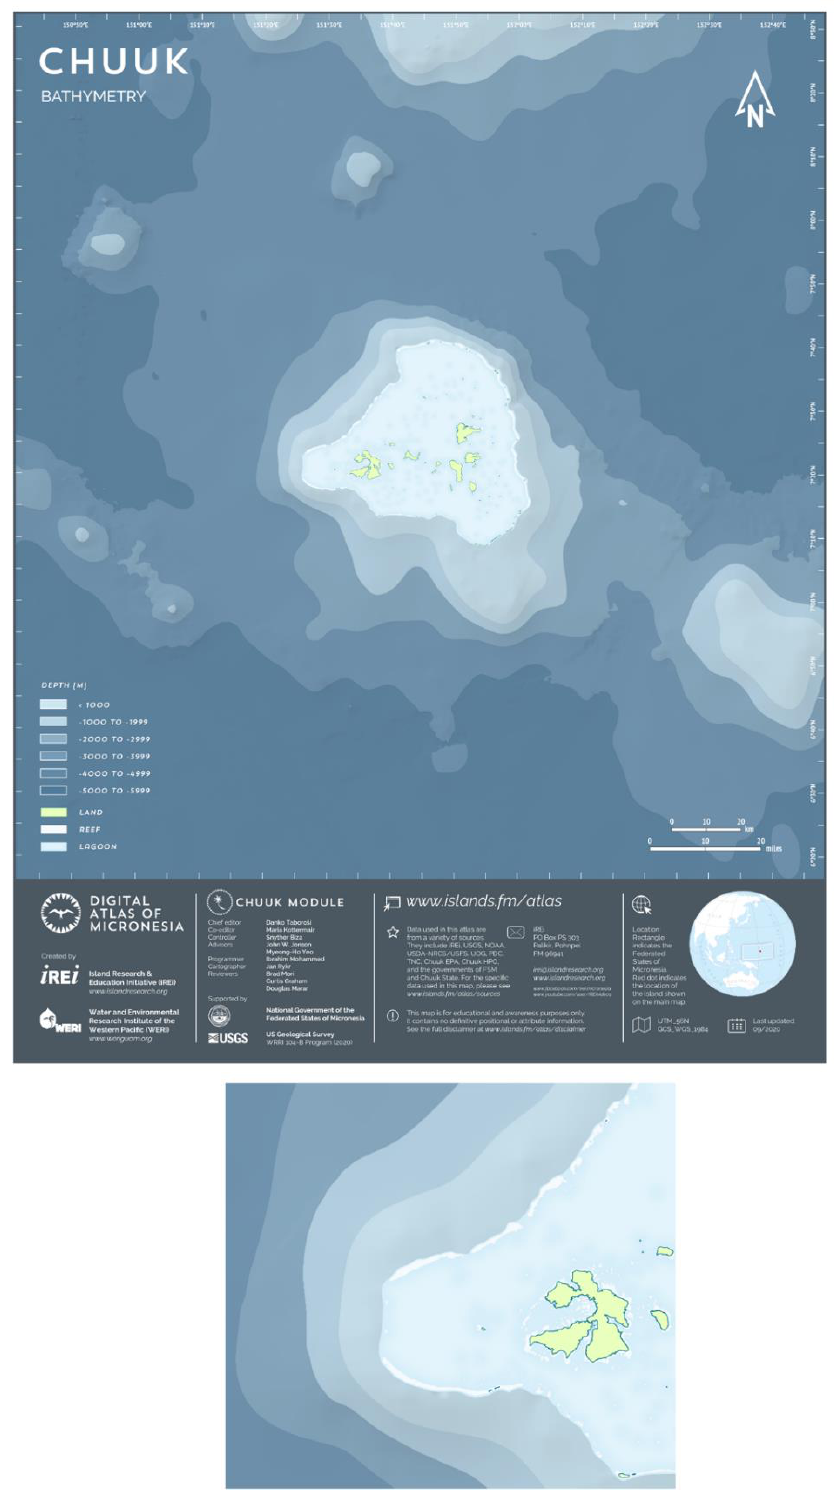
Figure 14. ( top ) Bathymetric map of Chuuk Lagoon and surrounding waters [23]. This map is shown much smaller than full size; at full size, available at https://islandatlas.org/chuuk/reefs/ (accessed on 26 Aug 2022), it confirms the locations of the reefs of the atoll and the gaps between reefs that are apparent in the MODIS image shown in Figure 14. ( bottom ) Subset image from the full-size bathymetric map, showing the bathymetry on the west side of Chuuk Lagoon. White areas are atoll reefs.